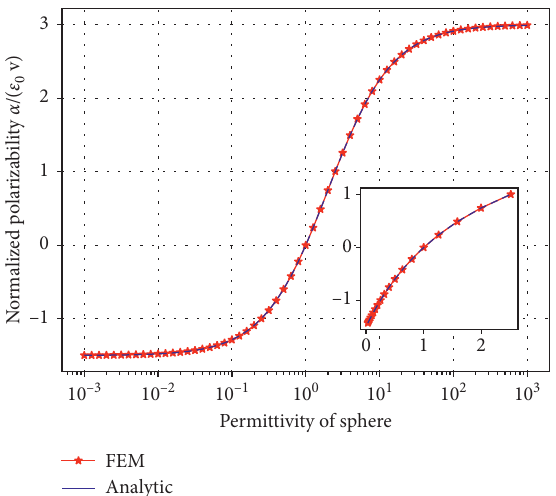
Figure 2: Relation curve between dielectric constant and nor- malized polarity of dielectric sphere with radius R .